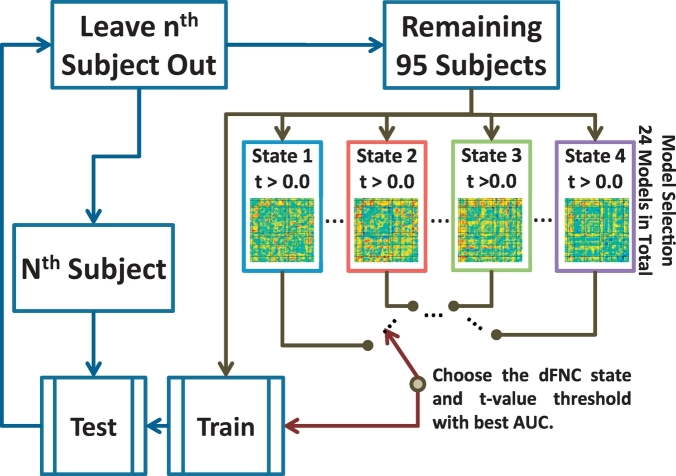
Schematic of the nested LOOCV loop used to identify the optimal state and feature selection threshold. Displayed matrices consist of t-values for each state. Features were selected using the t-values from two sample t-tests that were larger than one of the six thresholds [0.0 0.25 0.50 0.75 1.0 2.0]. In total there were 24 classification models (6 t-thresholds times 4 dFNC states). In this figure, the three dots between models indicate the existence of the other models.